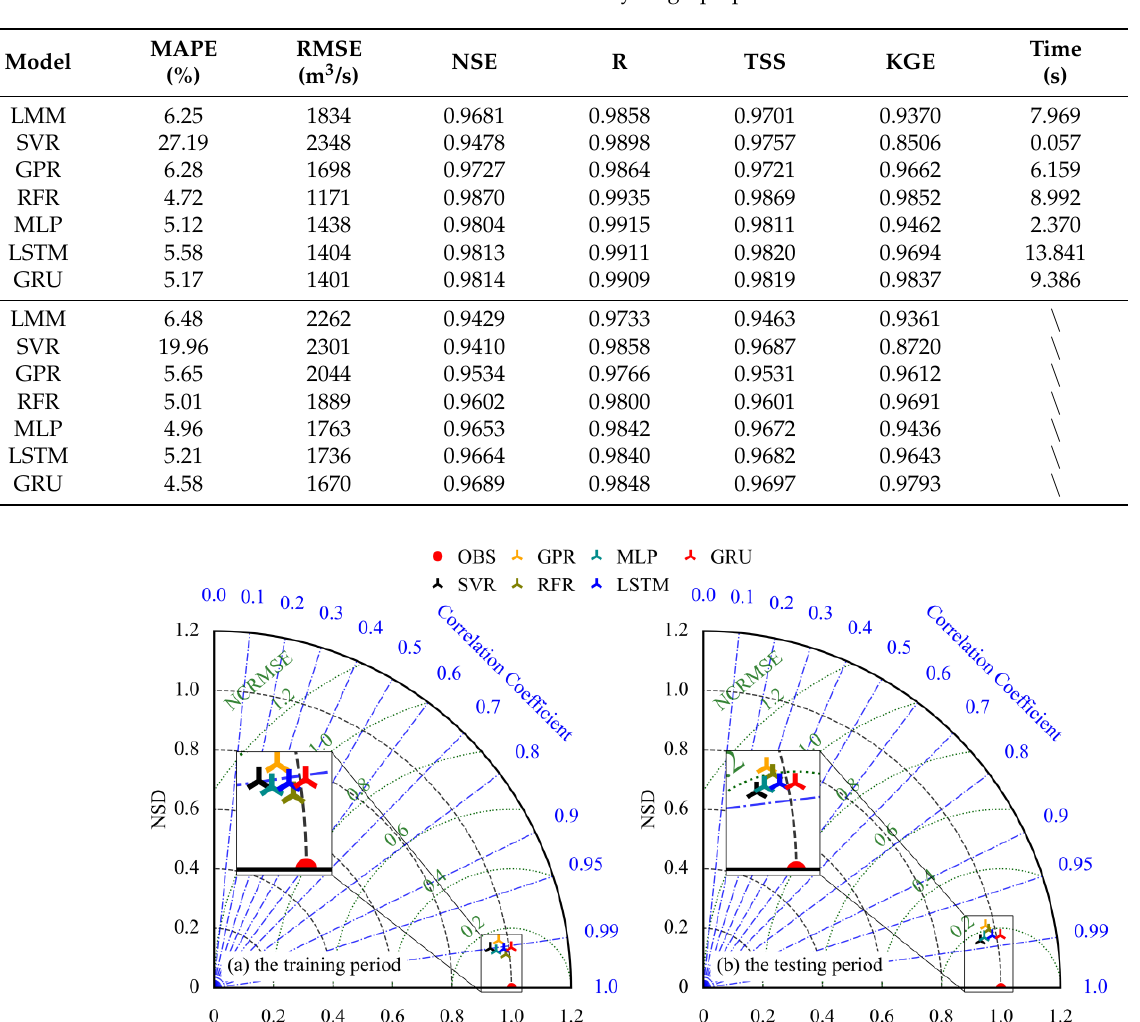
Table 1. Performance of the models for inflow hydrograph prediction of the TGR.